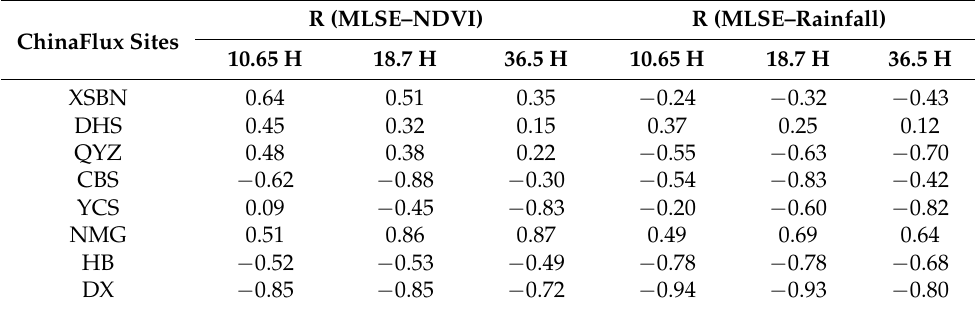
Table 6. Temporal correlation coefficient (R) of MLSE with MODIS NDVI and GPCC rainfall. ChinaFlux